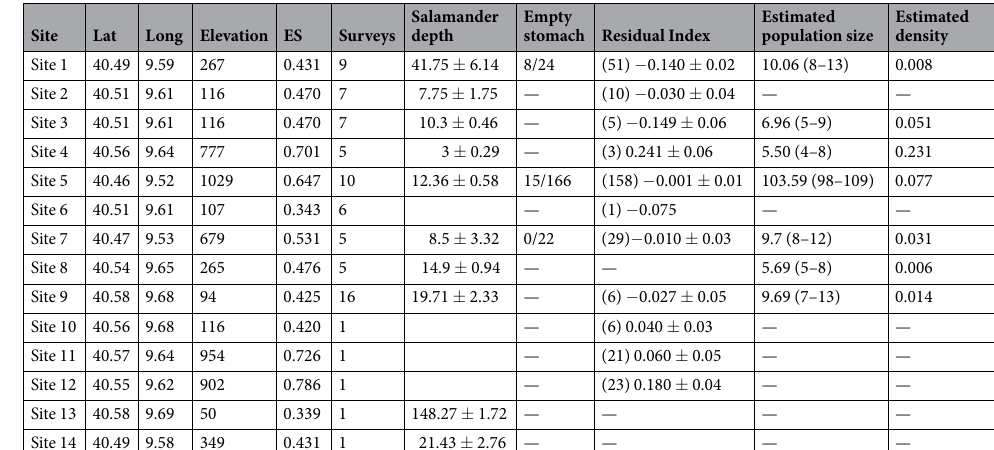
— — — Table 1. Monitored sites (caves). For each site we report: geographic coordinates; elevation (m a.s.l.); environmental suitability (ES); total number of performed surveys; average depth of observed salamanders ( ± SE); number of empty and sampled stomachs; body condition index (residual index ± SE; in parenthesis the N of salamanders); estimated population size (mean and 95% CI); estimated density (salamanders/m 2